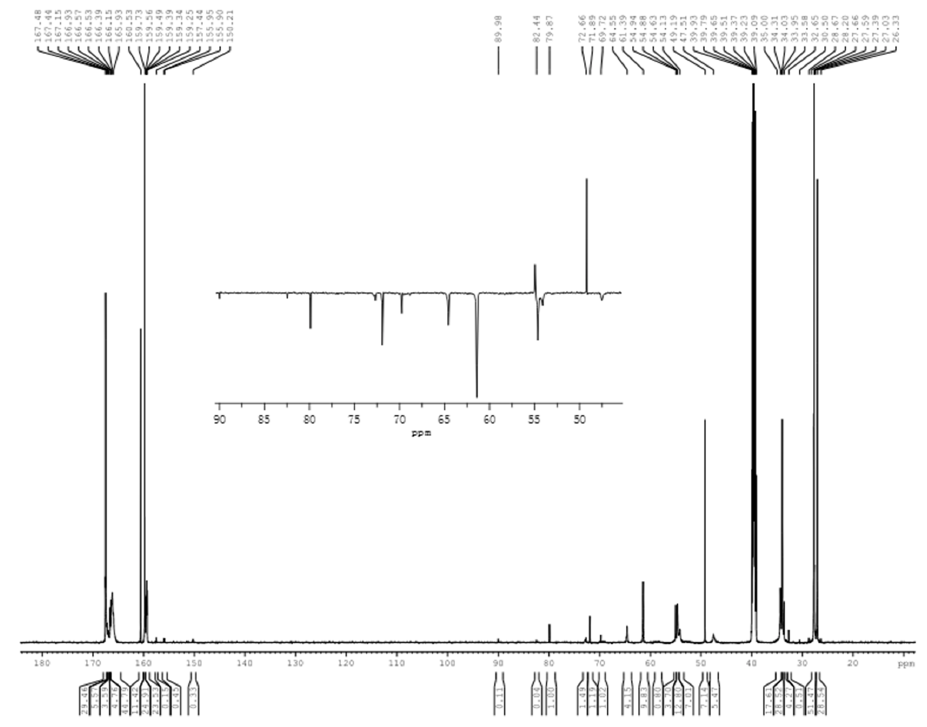
Figure 8. The 13 C-NMR spectrum of sample C2.